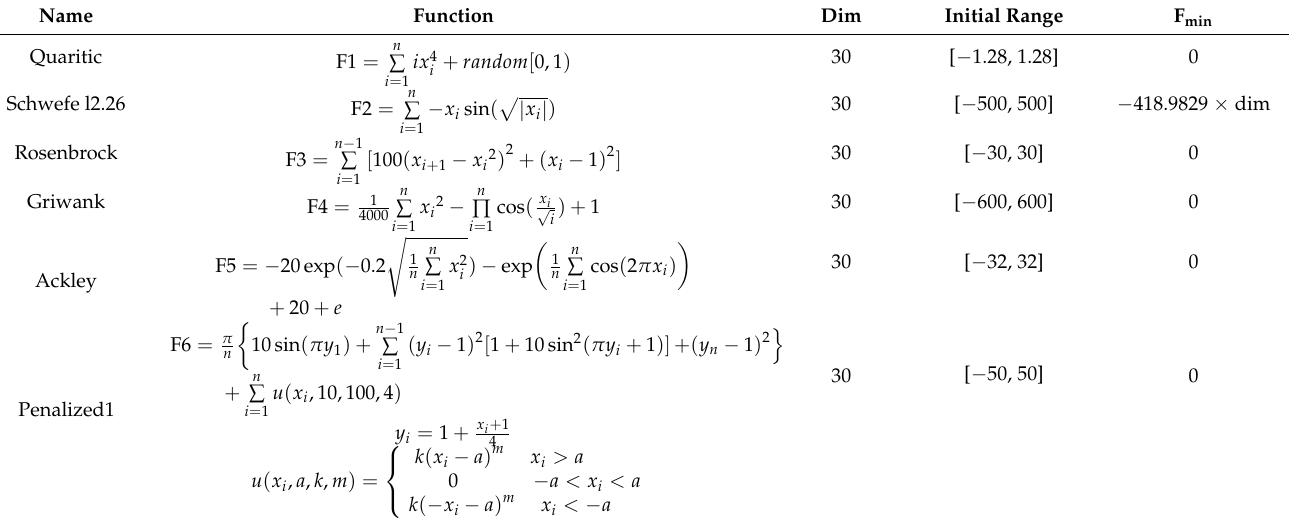
Table 1. Test Function (Dim = 30).